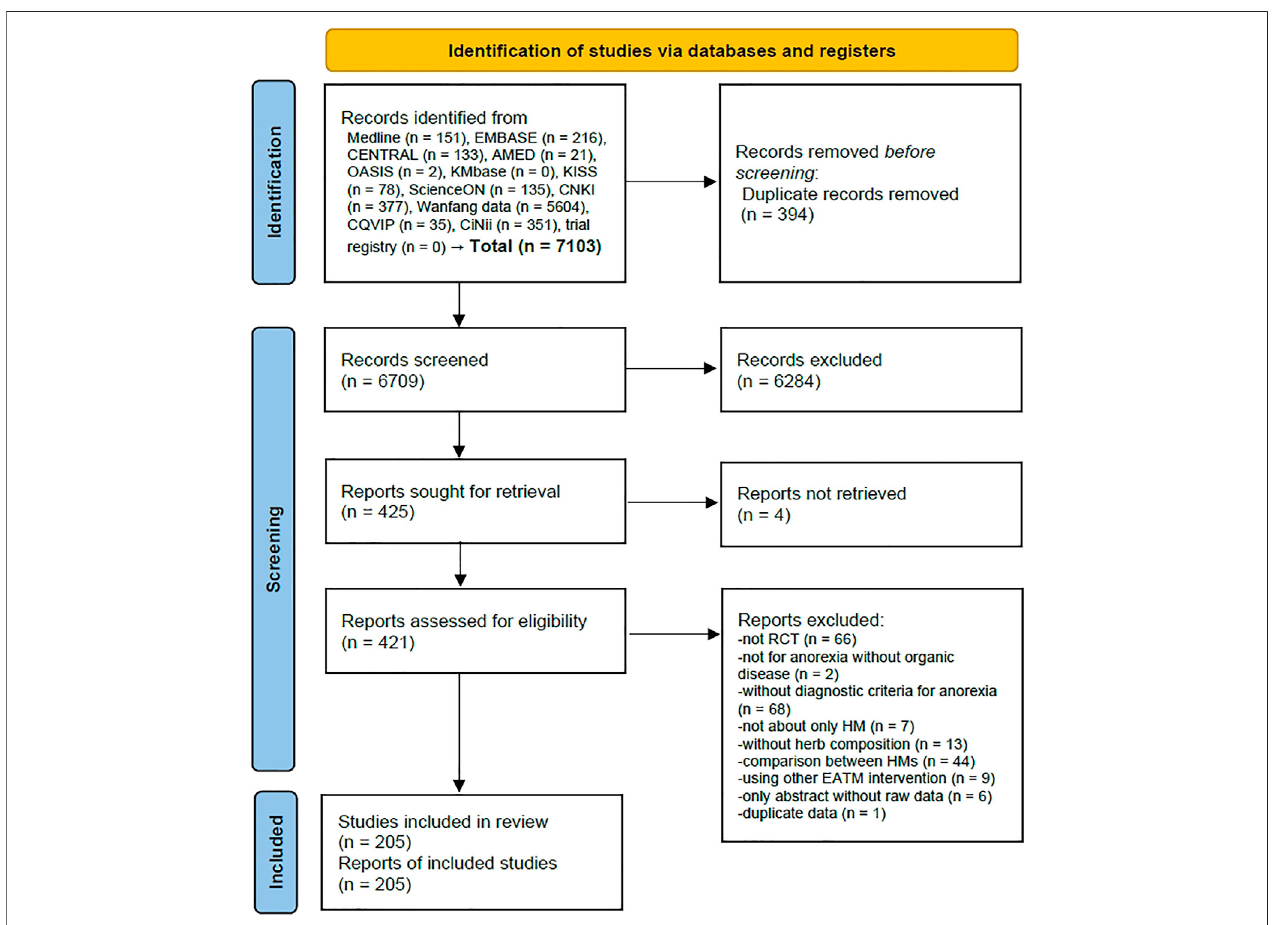
FIGURE 1 | PRISMA 2020 fl ow diagram. No studies were identi fi ed from other sources (Google scholar and citation searching). Abbreviations: AMED, Allied and ComplementaryMedicineDatabase;CENTRAL,CochraneCentralRegisterofControlledTrials;CNKI,ChinaNationalKnowledgeInfrastructure;CQVIP,ChongqingVIP; EATM, East Asian traditional medicine; HM, herbal medicine; KISS, Koreanstudies Information Service System; KMbase, Korean Medical Database; OASIS, Oriental Medicine Advanced Searching Integrated System; RCT, randomized controlled